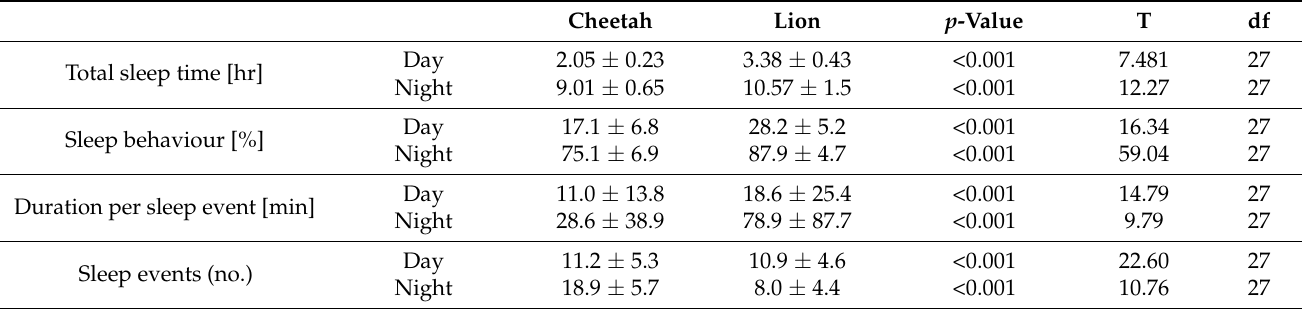
Table 3. Sleep behaviour of lions and cheetahs. Cheetah Lion p